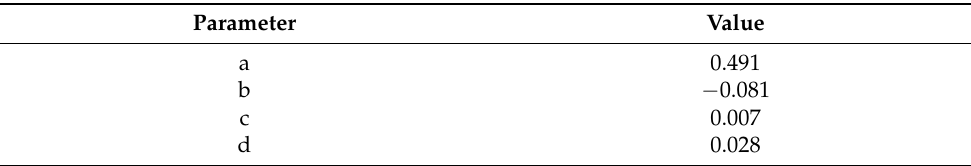
Table 4. Values of equation parameters for radial tire.